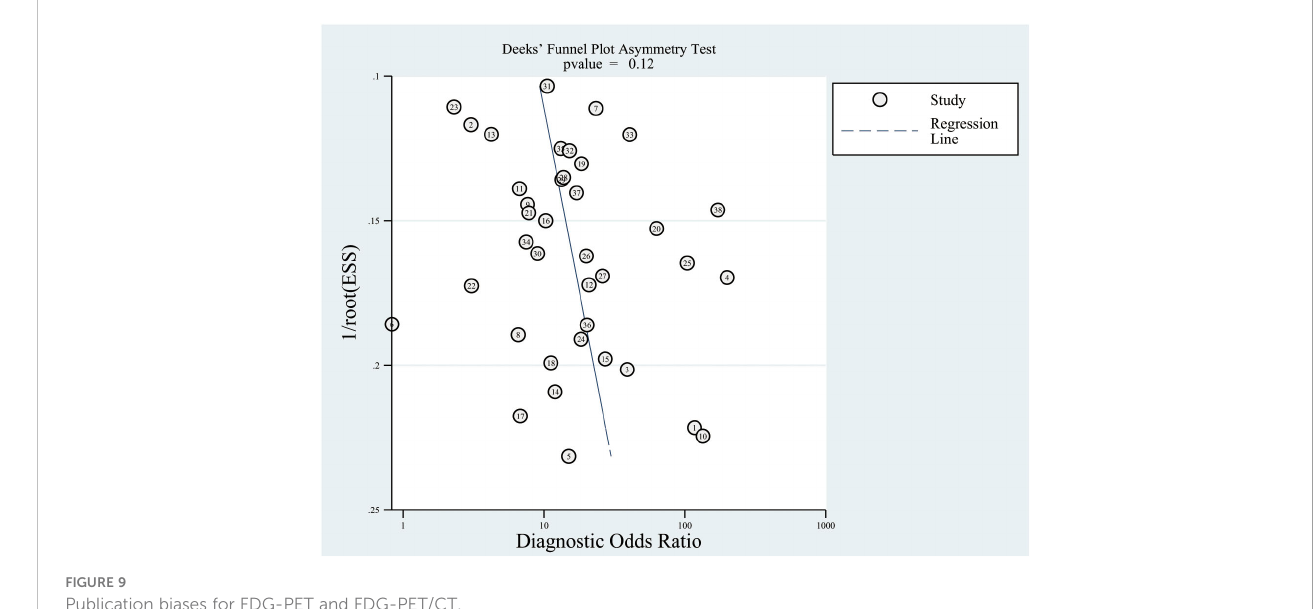
FIGURE 9 Publication biases for FDG-PET and FDG-PET/CT.